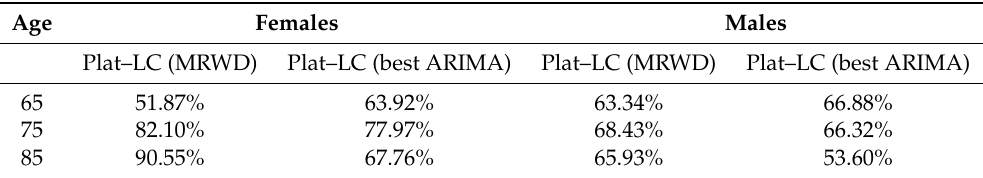
Figure A2. Mortality rate projections at age 65, 75, 85 with parameters uncertainly with Plat–LC model (best ARIMA processes) for ( a ) female Maltese population, ( b ) male Maltese population. Table A1. Relative amplitude of prediction intervals for Maltese death rates in 2046 with Plat–LC model with different ARIMA